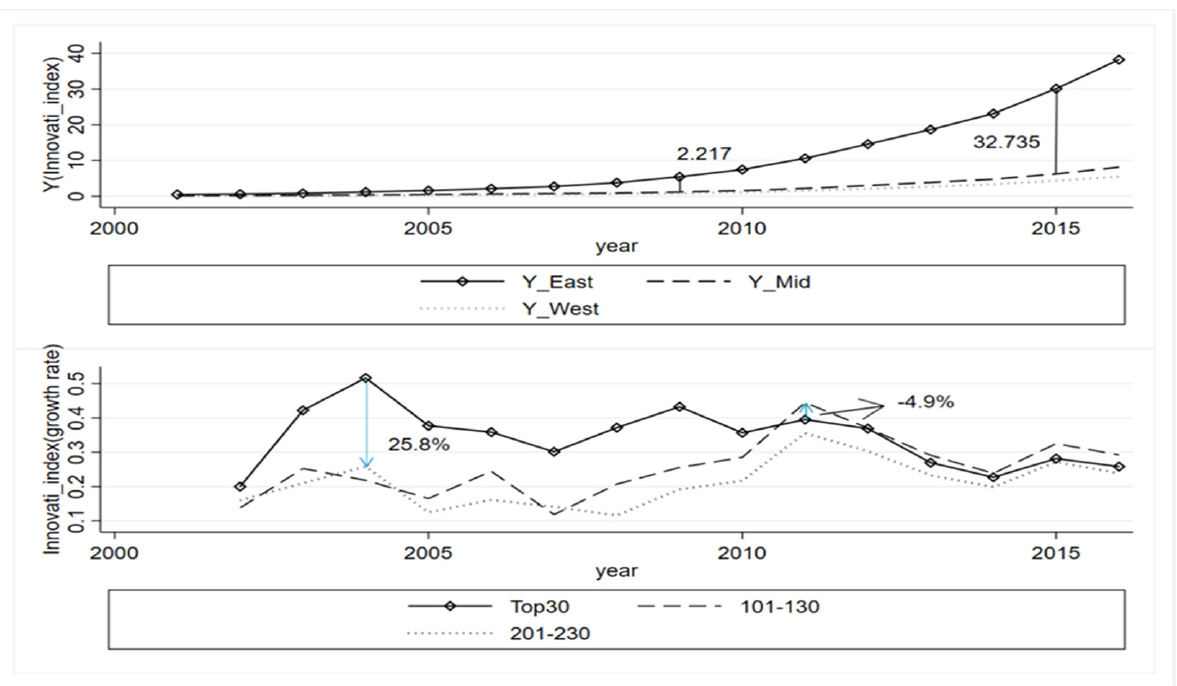
Figure 1. Dynamic evolution of urban innovation capacity.